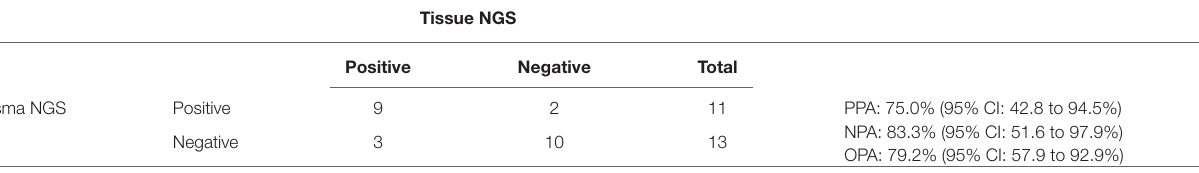
TABLE 4 | Panel-wide concordance of actionable mutations in 24 NSCLC cases that underwent both the tissue and plasma NGS testing.